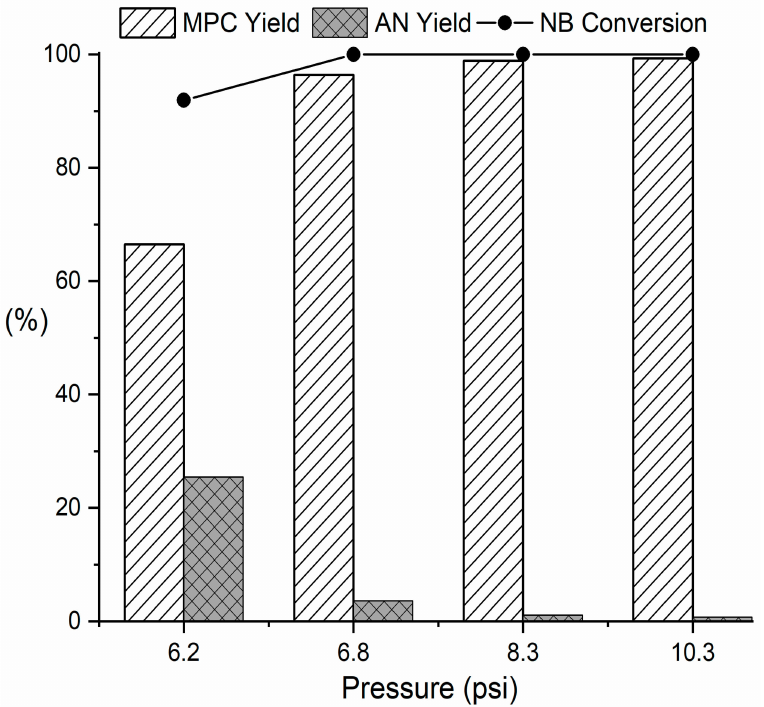
Figure 5. E ff ect of pressure on the formation of MPC at 160 ◦ C for 4 h in the presence of 1 g of 5 wt% FeSe 2 / γ -Al 2 O 3 . Conditions: NB (20 mmol), 5 wt% FeSe 2 / γ -Al 2 O 3 (1 g, [FeSe 2 ]: 0.2338 mmol), molar ratio of NB / FeSe 2 = 85, MeOH (30 mL), T = 160 ◦ C, t = 4